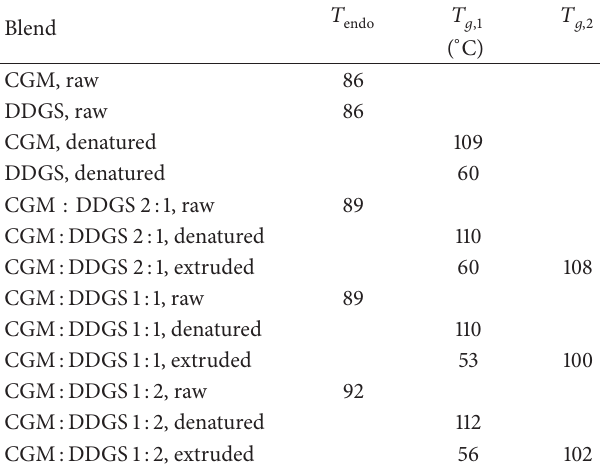
Table 2: Thermal events for CGM, DDGS, and blends